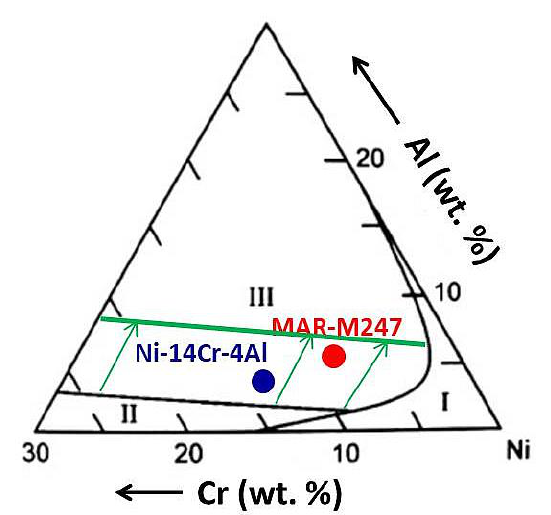
Figure 15. Oxidation map developed by Giggins and Pettit [2] with interpolated Cr and Al content for MAR 247 and Ni-14Cr-4Al alloys showing the effect of surface smoothening by